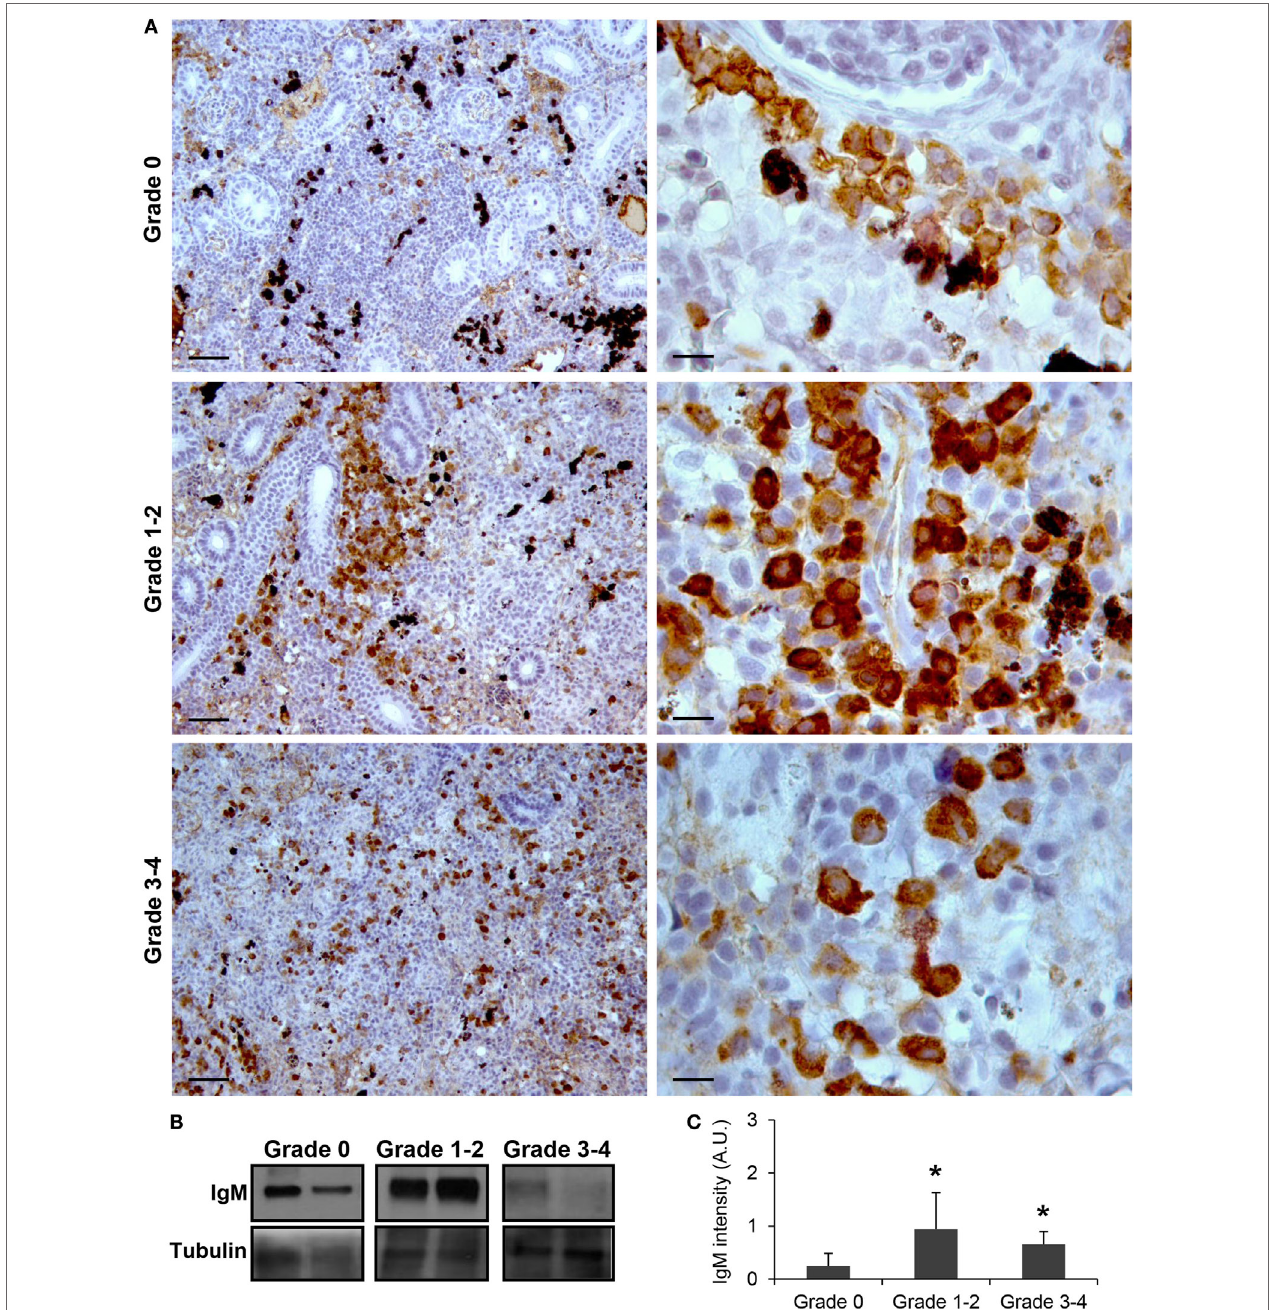
FigUre 1 | IgM production increases during proliferative kidney disease infection. (a) Immunohistochemical detection of IgM + cells in the kidney of parasite­infected (swelling grades 1–4) and parasite­naïve (swelling grade 0) fish. Representative images for fish with grade 0, grade 1–2, and grade 3–4 are shown at 20 × magnification (left images, scale bars = 50 µm) and at 100 × magnification (right images, scale bars = 10 µm). IgM production in kidney samples from each fish group was analyzed by Western blot. (B) Results from two representative individuals in each group are shown. (c) Abundance of IgM was quantified by optical densitometry and normalized against α ­tubulin. Mean values in arbitrary units (A.U.) + SEM are shown ( n = 4). Asterisks (*) denote significant differences ( P < 0.05) between values obtained in grade 1–2 or grade 3–4 and grade 0 kidneys (analyzed by a two­tailed Student’s t